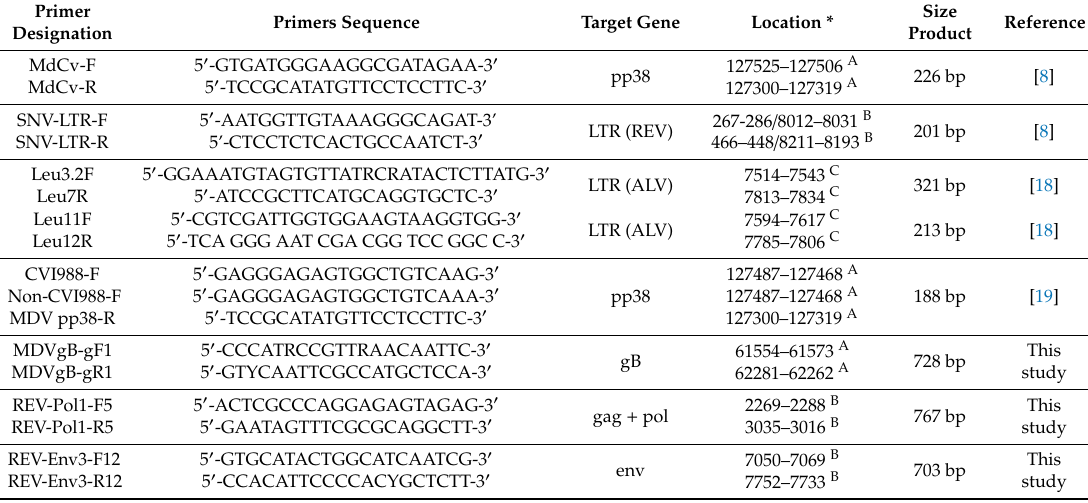
Table 1. Detailed list of the primers used in this